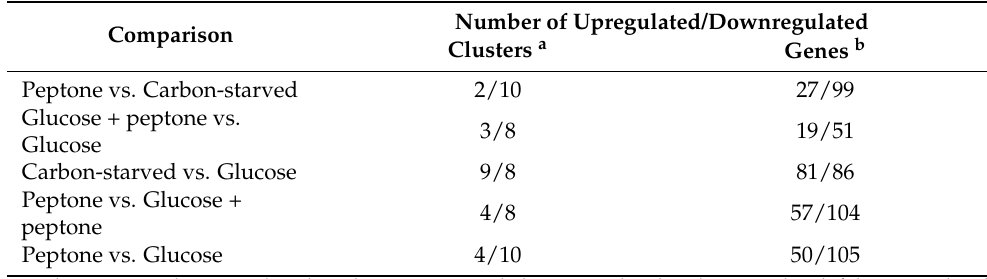
Table 4. Transcriptional behavior of secondary metabolite clusters and cluster genes in carbon- stressed A. fumigatus cultures. Number of Upregulated/Downregulated Comparison Clusters a